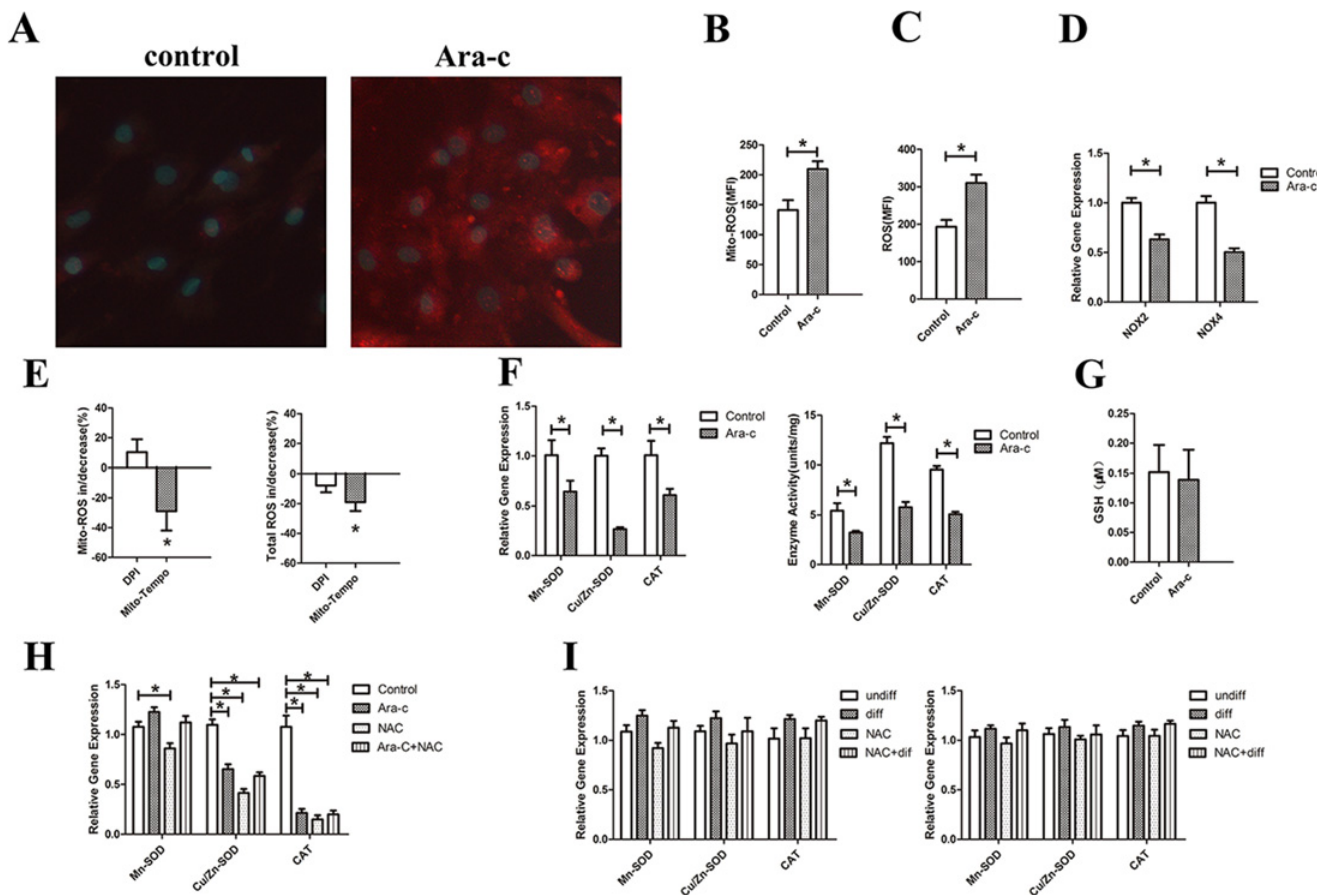
Fig 3. The potential mechanism for the elevated ROS levels. (A) Detection of mitochondrial ROS in live cells. Live MSCs were treated with Ara-C (100 mM for 24 hours) or without. Red fluorescence indicates the presence of mitochondrial ROS, while blue fluorescence indicates nuclei stained with Hoechest 33342. (B) Median Fluorescence Intensity (MFI) of mitochondrial ROS in the control and Ara-C groups. (C) MFI of total ROS measured by the CM-